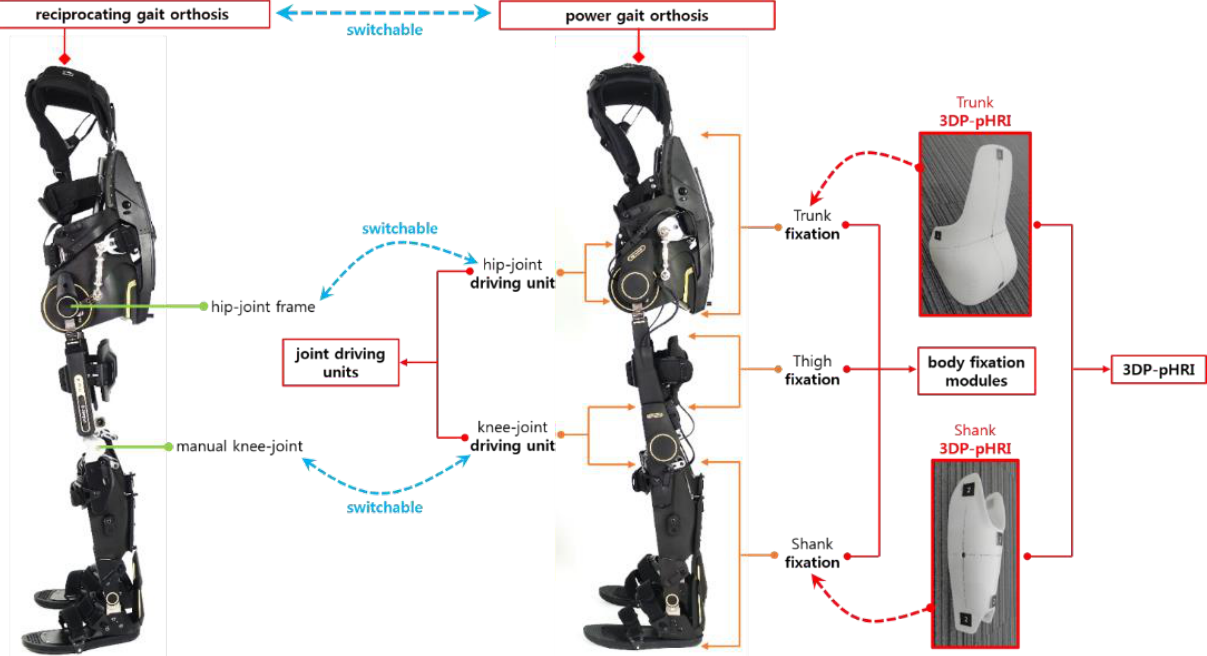
Figure 1. Hardware configuration of the wearable robot.